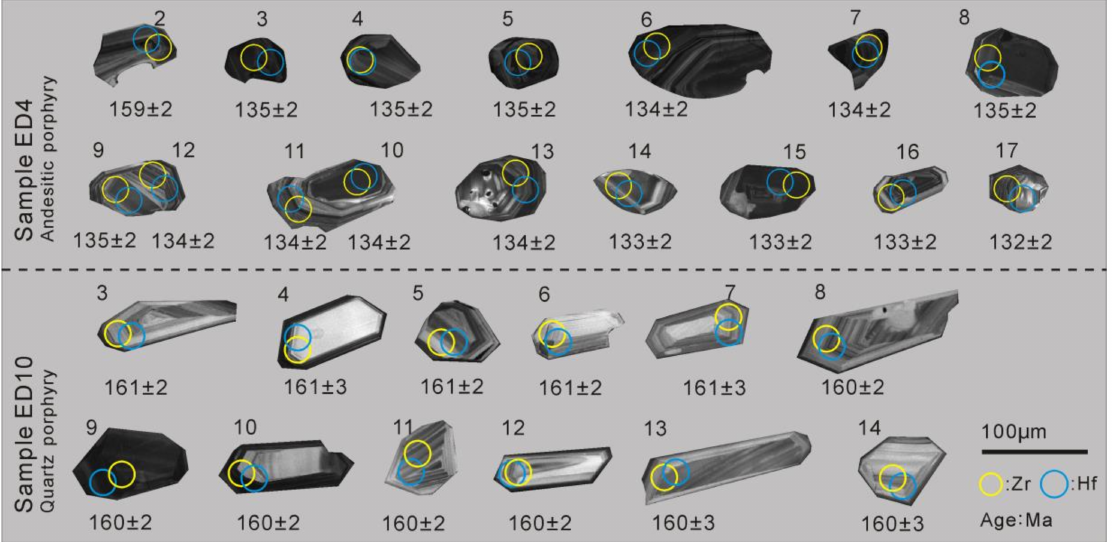
Figure 4. ( A ) Cathodoluminescence (CL) images of zircons from the quartz porphyry; ( B ) CL images of zircons from the andesite porphyry. The yellow circle represents the U–Pb age analytical spot, and the blue circle represents the Hf isotope analytical